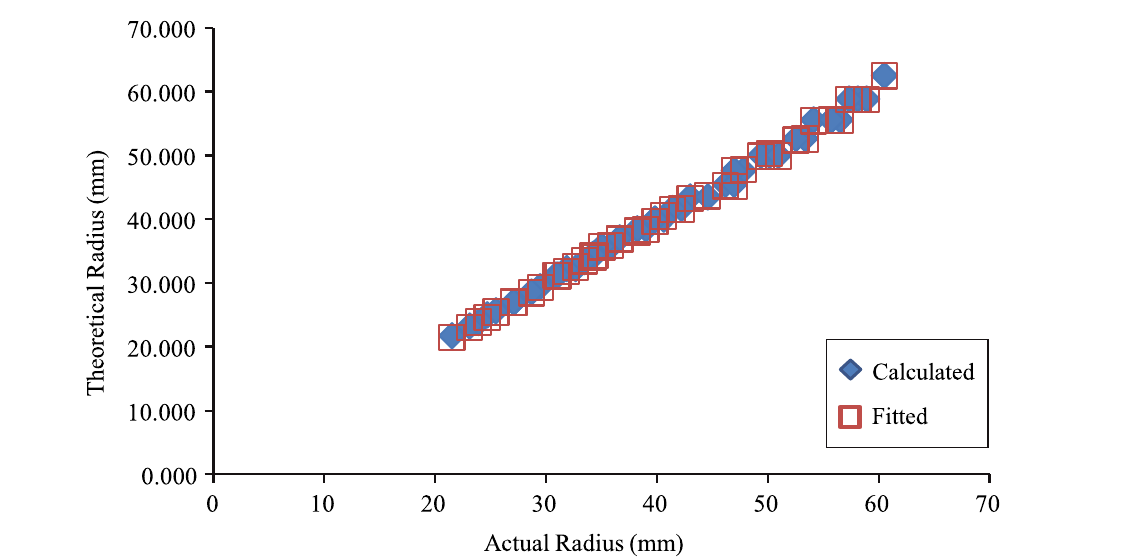
FIG. 6. GRAPH BETWEEN THE ACTUAL AND THEORETICAL RADII FOR THE CYLINDRICAL BODY PARTS OF SUBJECTS